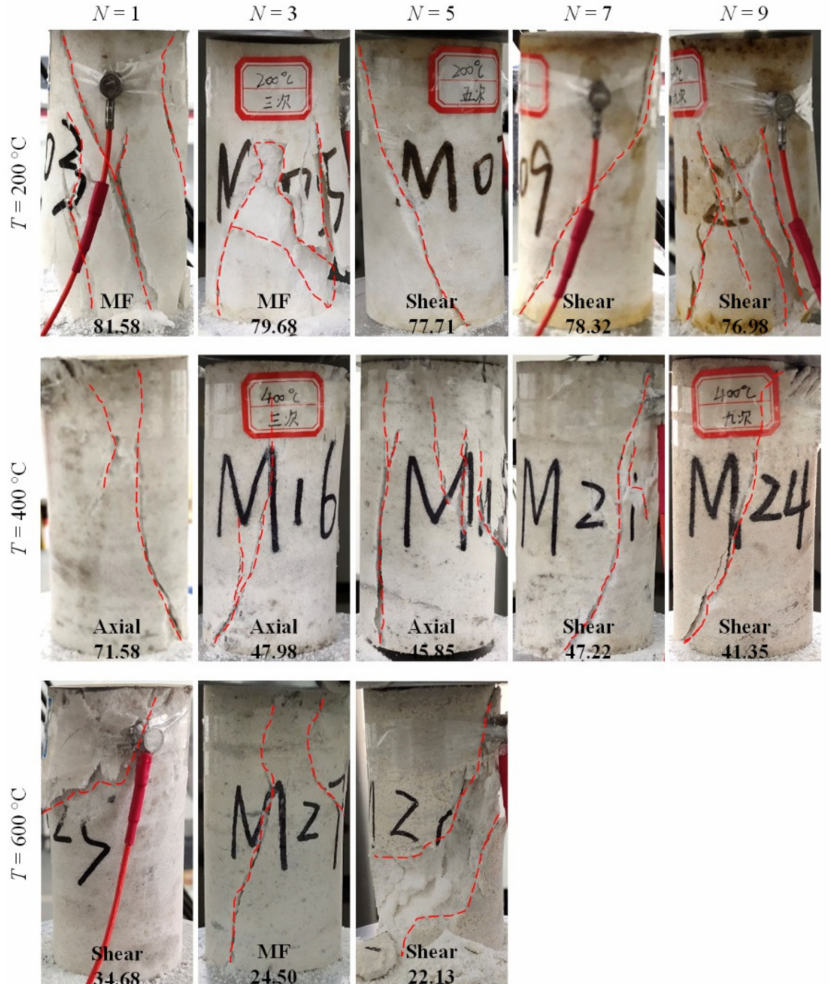
Figure 6. Ultimate failure modes for marble specimens at different thermal shock numbers. Failure modes and corresponding compressive strength (in MPa) are marked. (Axial denotes axial splitting, MF denotes multiple fracturing, Shear denotes shearing